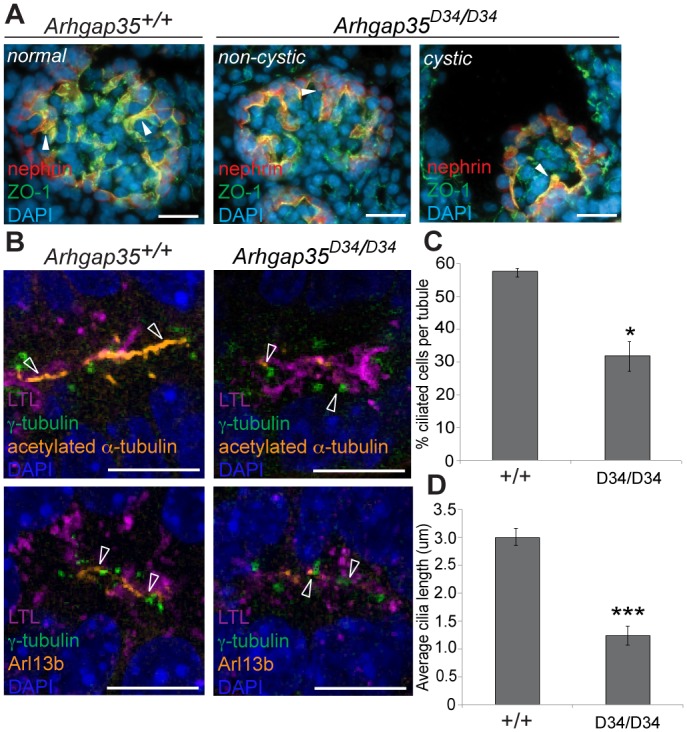
Glomerulocystic phenotype in Arhgap35D34/D34 is associated with a ciliogenesis defect.(A) Immunofluorescent staining of control and mutant glomeruli sections at E17.5 show that podocytes (marked by nephrin expression) form ZO-1+ tight junctions, reflective of an intact slit diaphragm (closed arrowheads). Scale bars, 10μm (B-D) Immunofluorescent staining for acetylated α-tubulin and Arl13b in proximal tubules (marked by Lotus Tetragonolobus Lectin; LTL)(panel B) shows a significant decrease in the number (panel C) and length (panel D) of ciliated cells in Arhgap35D34/D34 animals compared to wild type (open arrowheads). Scale bars, 5μm. *p<0.05, **p<0.01, ***p<0.005 (unpaired, two-tailed Student’s t-test)